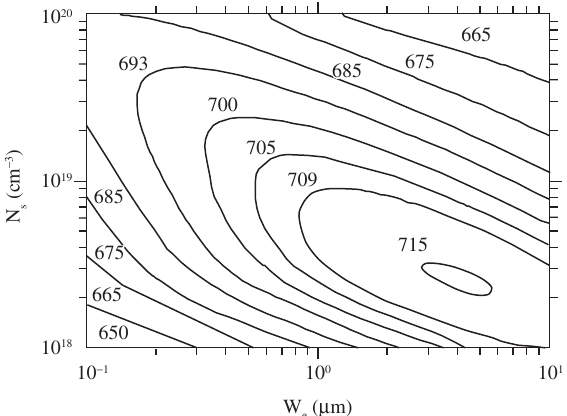
Figure 7. Open-circuit voltage contour plots, V doping concentration, N base resistivity 1 Ω .cm.